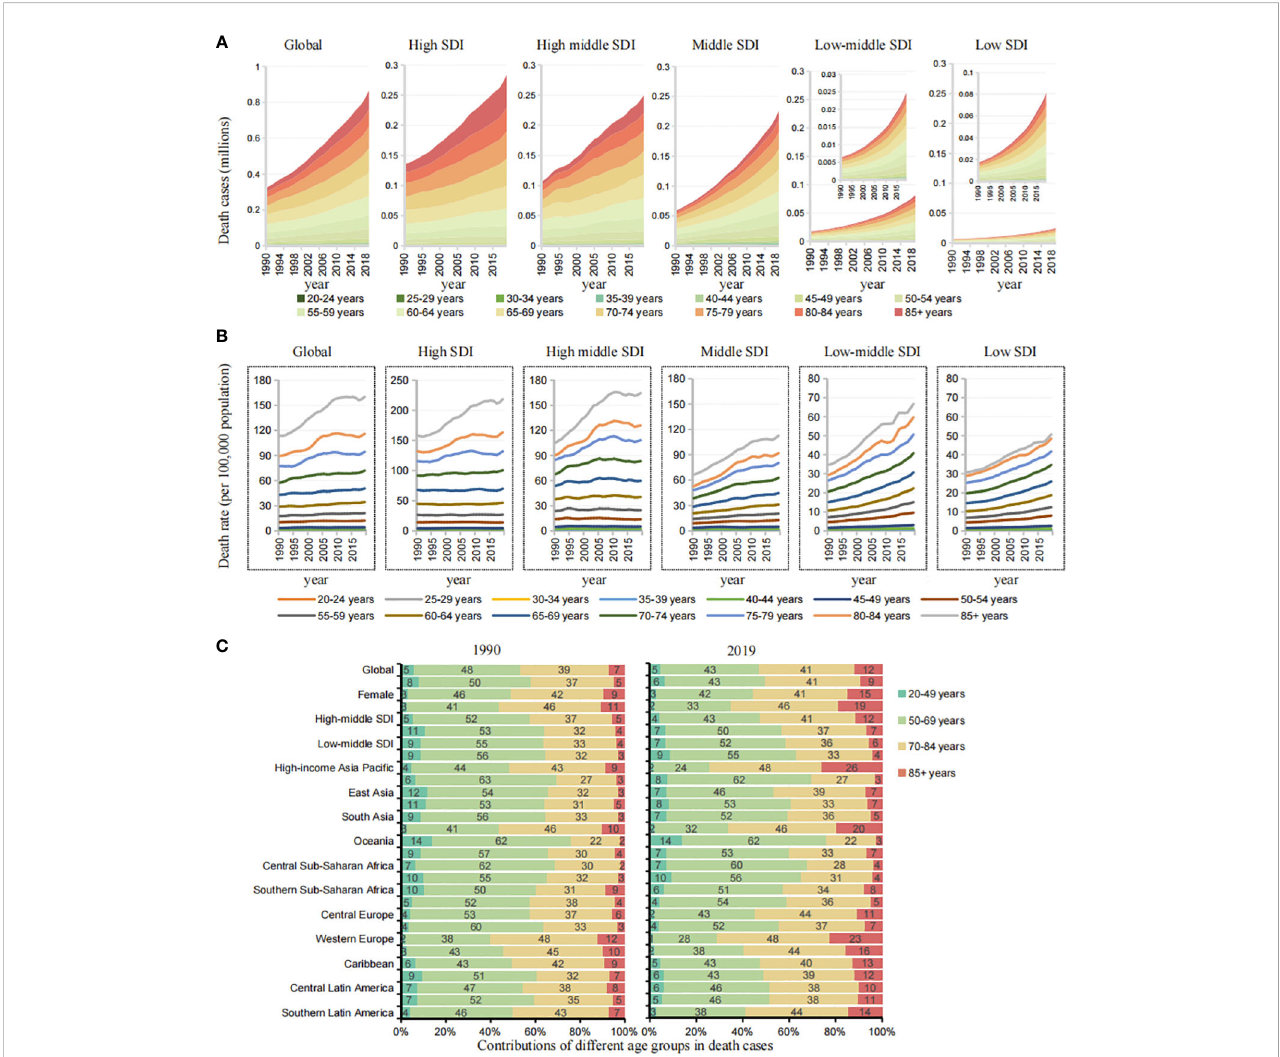
FIGURE 4 Age group differences and trends of cases in cancers by different SDIs and GBD regions. (A) The death cases trend of age groups in cancers attributable to metabolic factors by SDIs from 1990 to 2019. (B) The death rate trend of age groups in cancers attributable to metabolic factors by SDIs from 1990 to 2019. (C) Contributions of four age groups to cancer deaths attributable to metabolic factors by SDIs and GBD regions in 1990 and